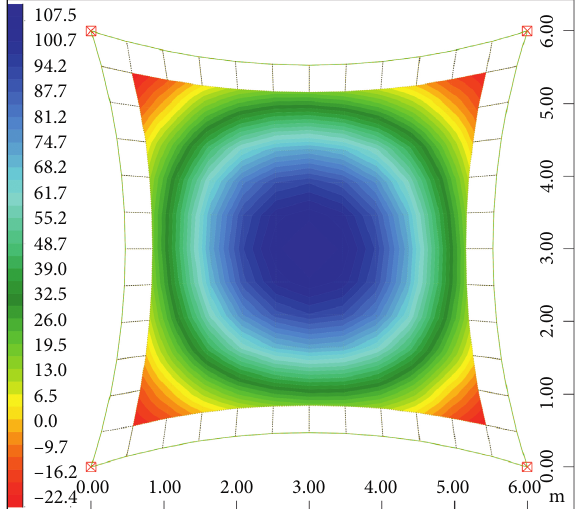
Figure 7: Difference in deflections caused by 1kN point load at different positions and 0.6kN/m 2 snow load in global Z direction